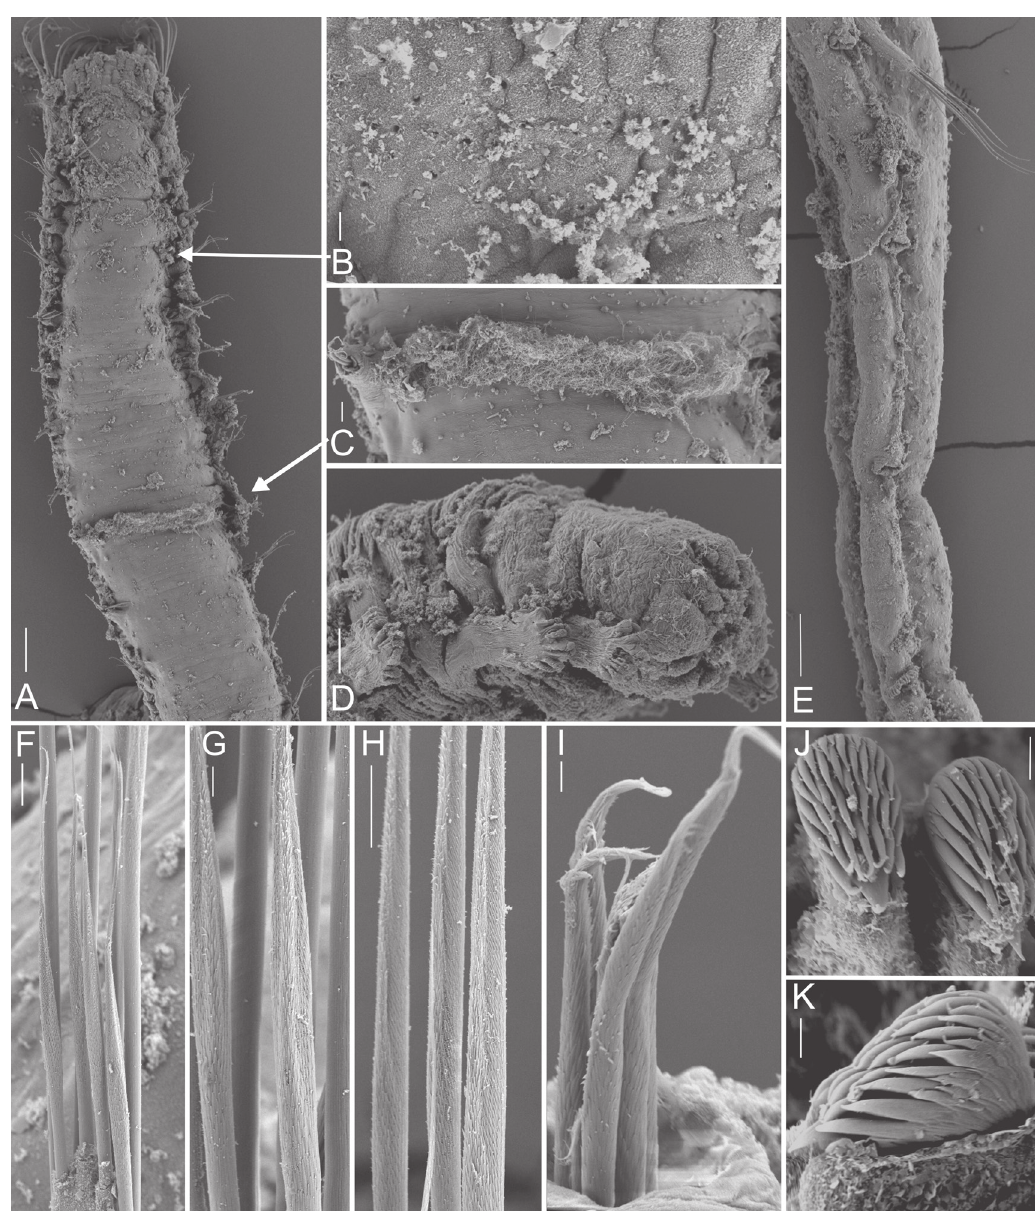
Fig. 6. Anobothrus konstantini Säring & Bick sp. nov. SEM micrographs. A . Anterior end and thorax, dorsal view, arrows: segment 6 (thoracic chaetiger 5, thoracic unciniger 1) and segment 12 (TC 11, TU 7), paratype (ZSRO-P2661). B . Pores in glandular band on segment 6 (TC 5, TU 1), dorsal view, paratype (ZSRO-P2661). C . Elevated ridge with cilia on segment 12 (TC 11, TU 7), dorsal view, paratype (ZSRO-P2661). D . Posterior end with papillose pygidium, lateral view, paratype (ZSRO-P2663). E . Last thoracic, two intermediate and first abdominal segments, lateral view, paratype (ZSRO-P2663). F . 4 longer and 3 shorter notochaetae of notopodium on segment 15 (TC 14, TU 10), paratype (ZSRO-P2661). G . Margin of short notochaetae on segment 15 (TC 14, TU 10), paratype (ZSRO-P2661). H . Margin of long notochaetae on segment 15 (TC 14, TU 10), paratype (ZSRO-P2661). I . Modified notochaetae on segment 12 (TC 11, TU 7), paratype (ZSRO-P2661). J . Abdominal uncini on abdominal segment 8, frontal view, paratype (ZSRO-P2663). K . Abdominal uncinus on abdominal segment 8, lateral view, paratype (ZSRO-P2663). Scale bars: A, E = 100 µm; B, I = 2 µm; C, D = 20 µm; F, H = 10 µm; G = 3 µm, J–K = 1